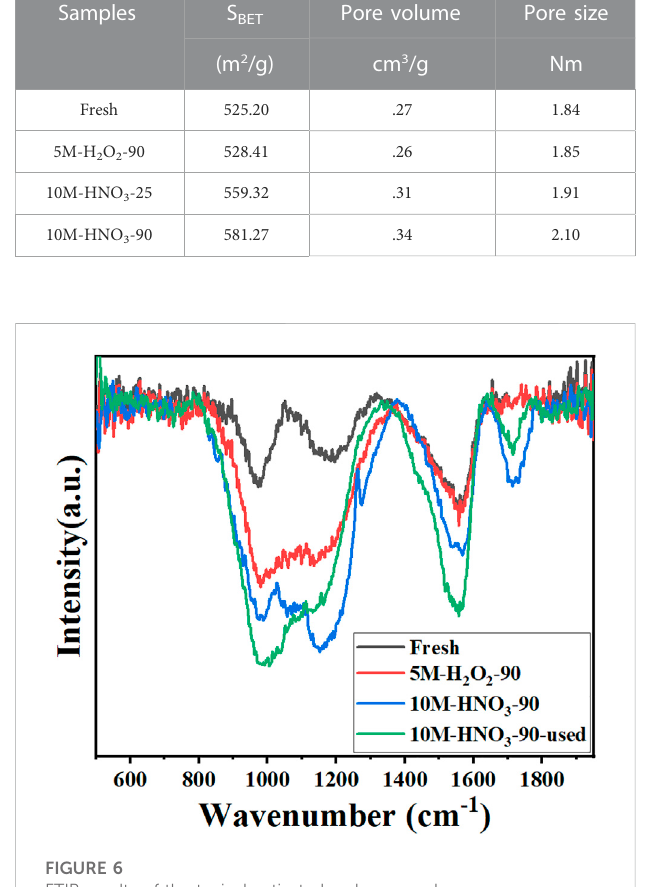
Figure 6. For the used 10M-HNO 3 -90 sample, much more weight loss